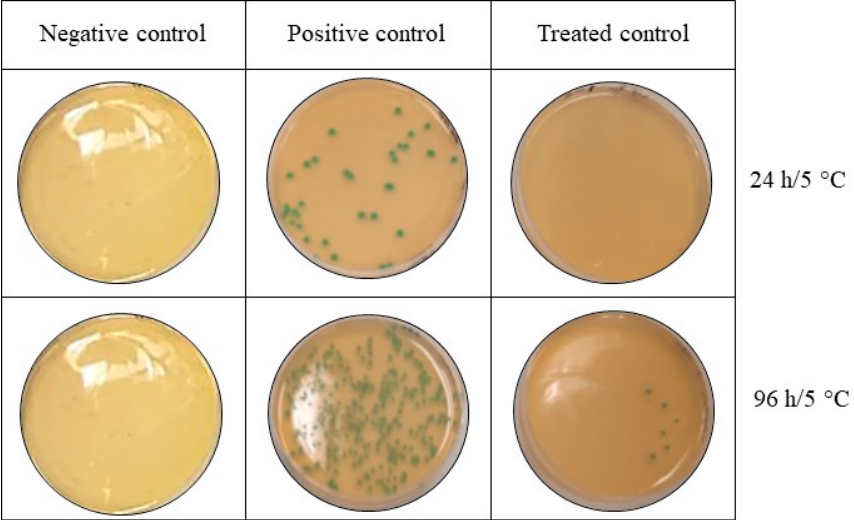
Figure 5. Bactericidal activity of polymer functionalized with 1018K6 against L. monocytogenes on salmon fillets. Negative control—untreated salmon fillets; positive control—salmon fillets treated with not-functionalized PP; treated control—salmon fillets treated with 1018K6-PP.